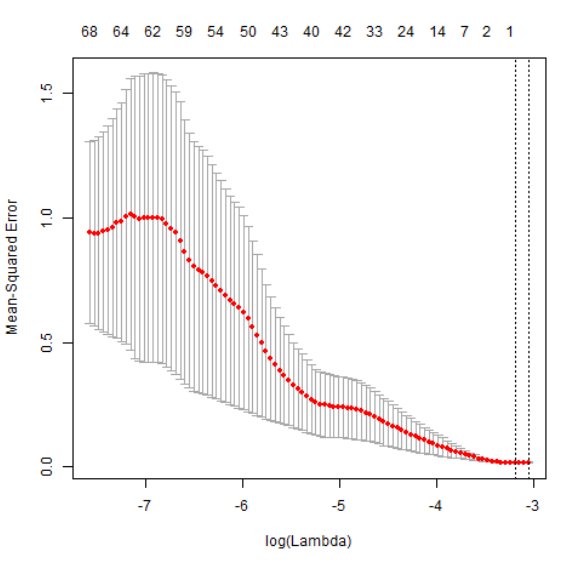
Figure 3. Lasso regression Lambda by crossvalidation Tags